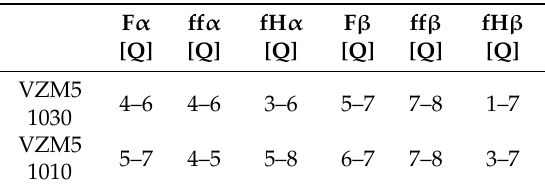
Table 18. Summary of gear qualities achieved of the hard machining tests, for inserts of type 1030 and 1010.